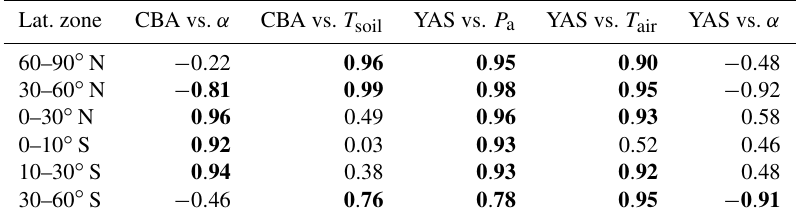
Table 3. The Pearson correlation r values for the different latitudinal zones between modelled heterotrophic respiration and the environmental drivers of the CBALANCE (CBA) and Yasso (YAS) models. The environmental drivers are all calculated as monthly means for the latitudinal zones. Significant correlation ( p value < 0.05) have been written in bold; α is the relative soil moisture, T soil and T air are soil and air temperature, and P a is the